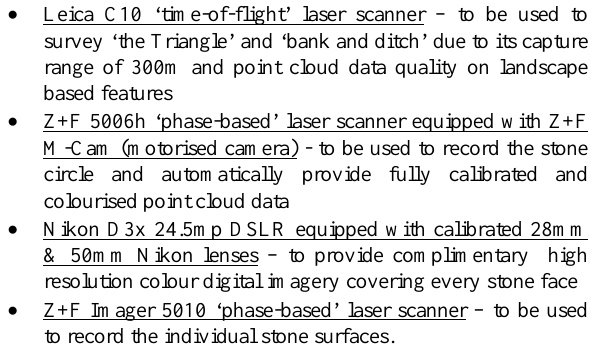
Topographic landscape - 10cm resolution Stone circle and surrounding ‘bank and ditch’ - 2cm for the landscape and 1mm for the stones Individual stone surfaces - 0.5mm resolution